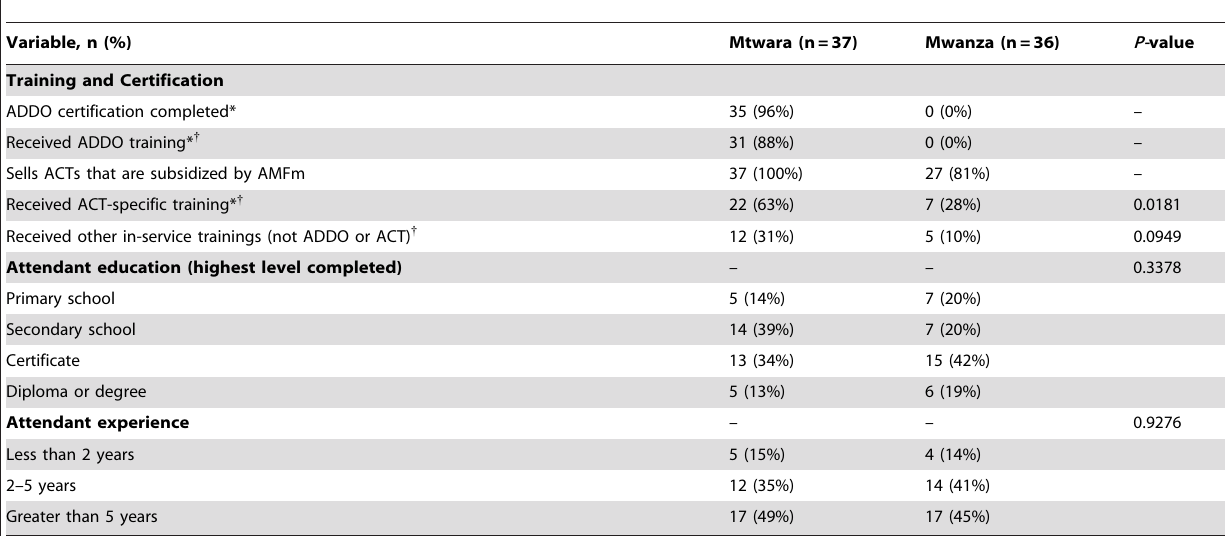
Table 1. Drug Shop and Drug Shop Attendant Characteristics Stratified by Region.